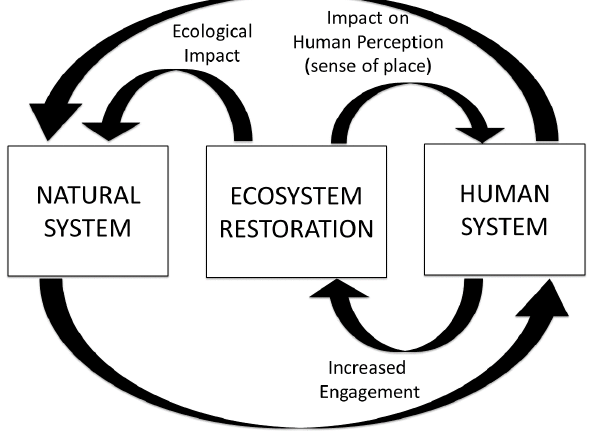
Fig. 1 . General conceptual model of a coupled human-natural system (sensu Ostrom 2009), incorporating the role of ecosystem